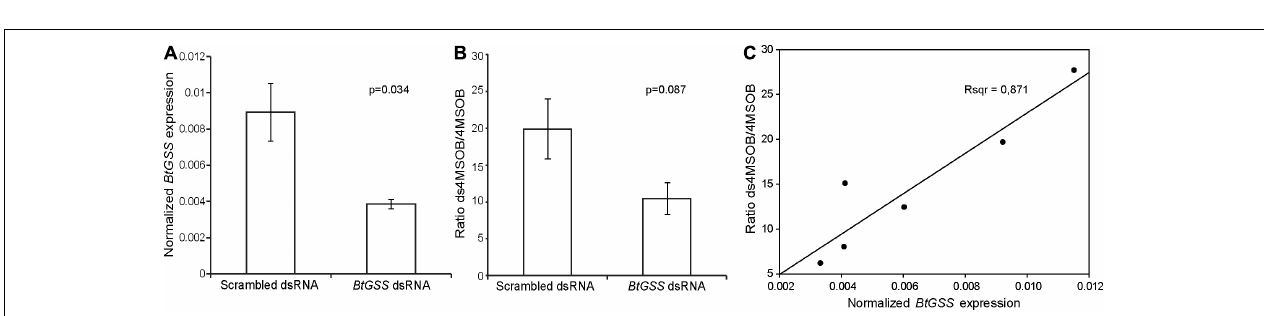
FIGURE 4 | BtGSS silencing in vivo . (A) Dietary administration of dsRNA ( N = 3 per treatment; statistical differences determined via t -tests) targeting BtGSS led to diminished expression of this gene (relative to rpl-13 ) compared with a treatment using a scrambled dsRNA control. (B) Silencing reduced the proportion of desulfo-4msob glucosinolate relative to intact glucosinolate present in whitefly honeydew. (C) BtGSS expression was positively correlated to the proportions of desulfo-4msob glucosinolate:intact glucosinolate in honeydew.